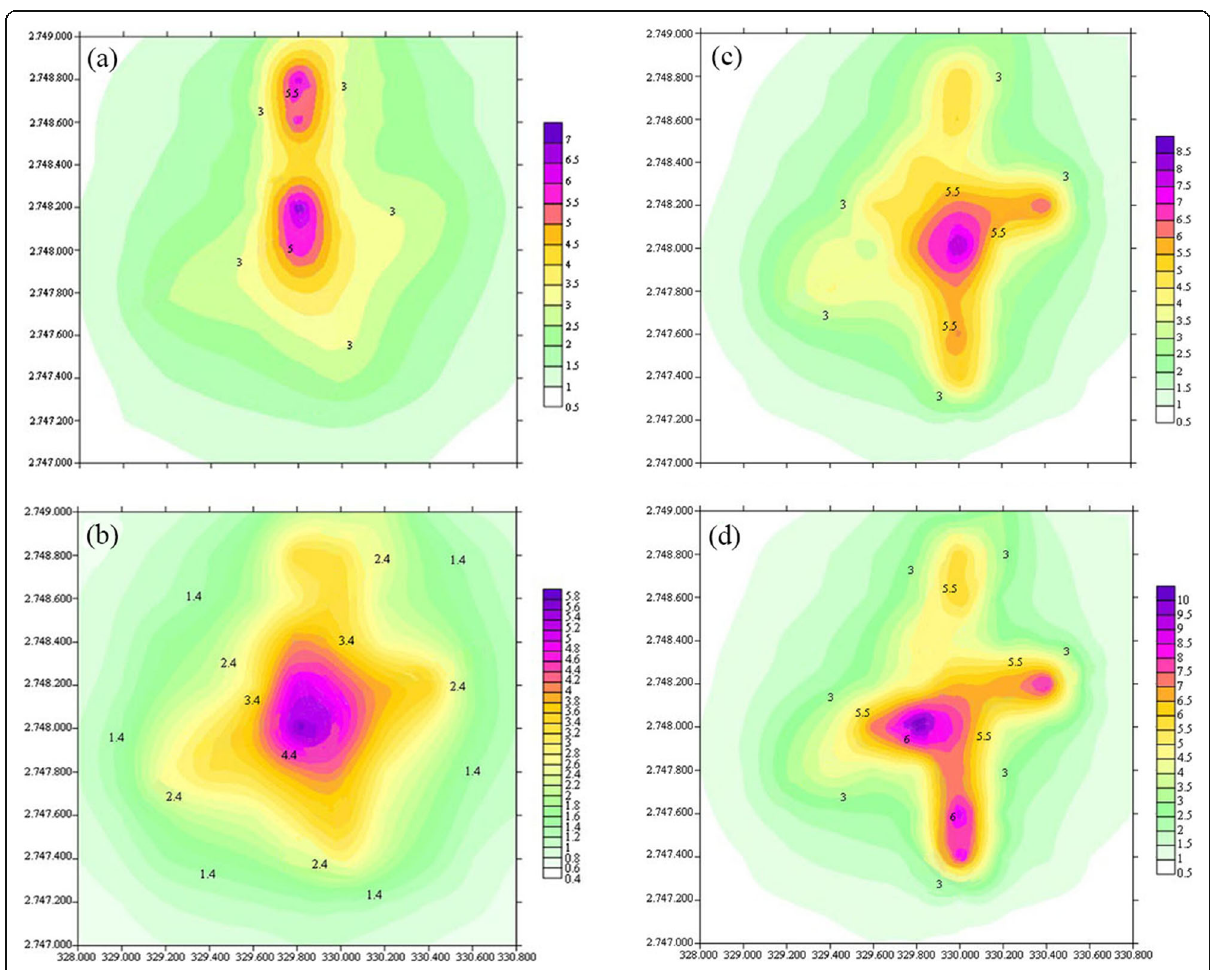
Fig. 8 Simulated hourly concentration of CO on the Toucheng highway intersection at ( a ) 9 m; b 7 m; c 5 m; and d 3 m. The x-axis and y-ax are Universal Transverse Mercator coordinate